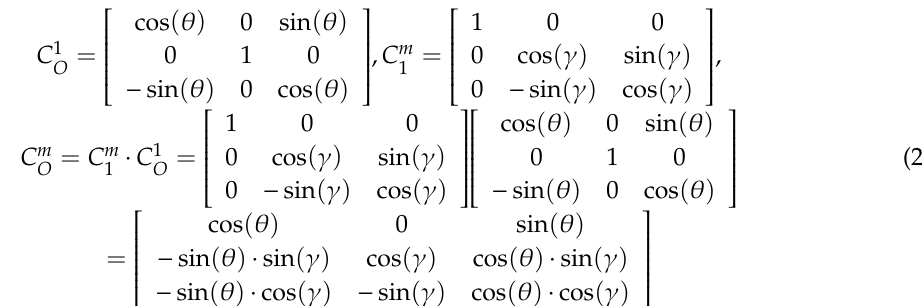
Figure 7. Reference coordinate system (OXYZ) and instrument coordinate system ( oxyz ).